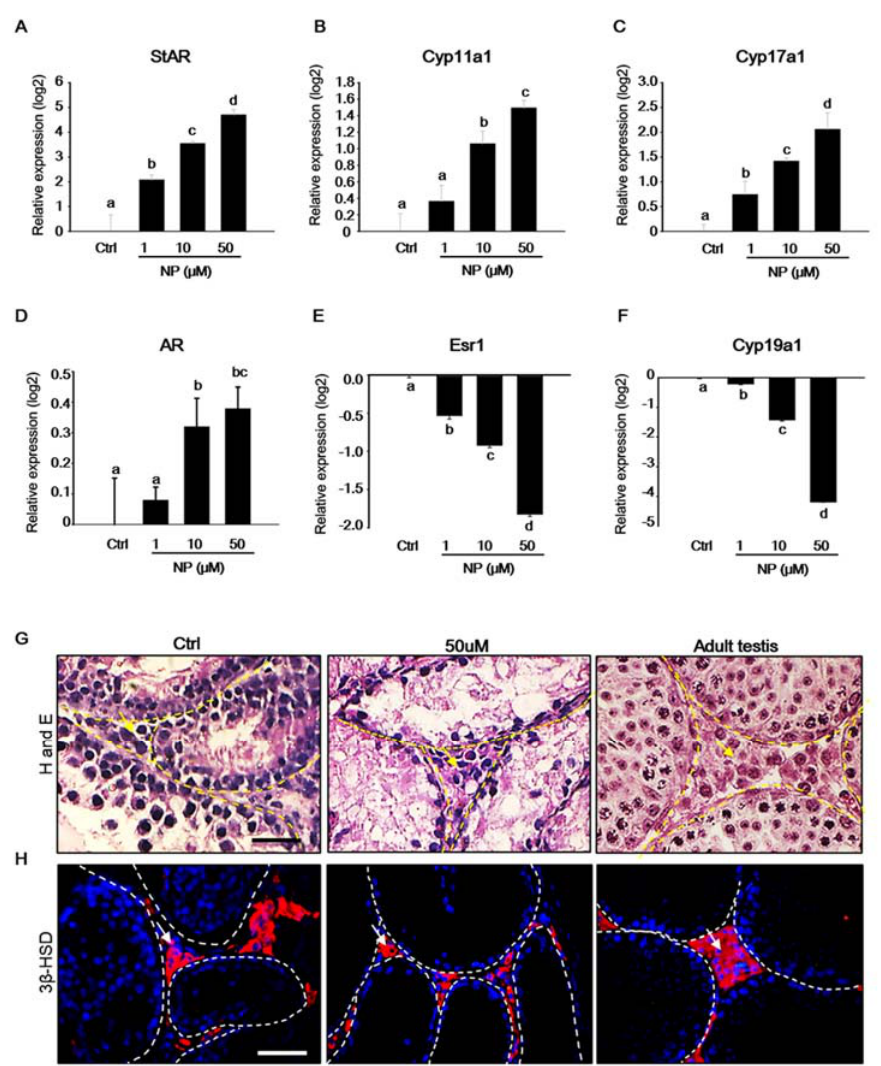
Figure 5. Expression of Leydig cell markers in the mouse testicular fragments (MTFs) after nonylphenol (NP) treatment. MTFs were cultured in the absence and presence of NP (1–50 µ M) for 30 days. ( A ) Star , ( B ) Cyp11 α 1 , ( C ) Cyp17a1 , ( D ) Ar , ( E ) Esr1 , and ( F ) Cyp19 α 1 mRNA levels in the MTFs were determined using quantitative polymerase chain reaction. The relative quantification of mRNA is shown as the mean and the standard error of the mean ( n = 6) at log 2 scale. The expression of steroidogenesis-related Leydig cell markers such as Star, Cyp11 α 1, and Cyp17a1 increased dose-dependently in the NP-treated MTFs. ( G ) The histological image shows that Leydig cells are located in the interstitial region in NP-treated (50 µ M) and untreated MTFs (indicated by yellow arrow), and adult testes were used as positive controls. Moreover, ( H ) 3 β -HSD protein was detected in MTFs with and without NP treatment by immunostaining (indicated by white arrow). Scale bars = 50 µ m. All of the images were acquired at the same magnification.